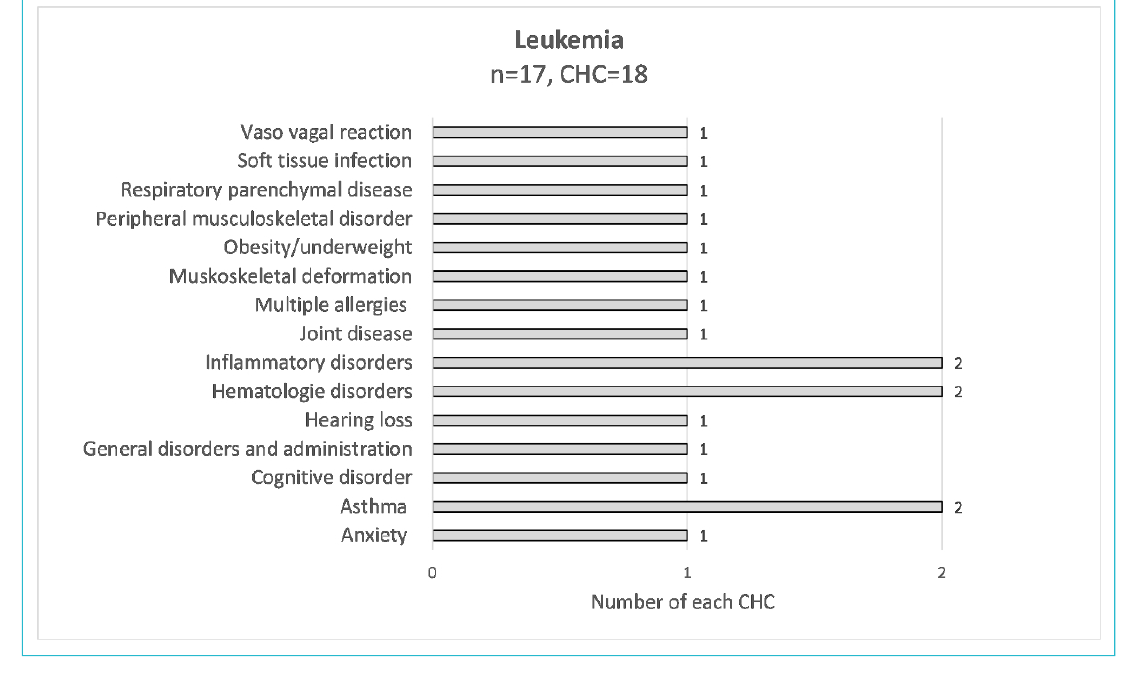
Figure S5: Distribution of chronic health conditions for each diagnosis;